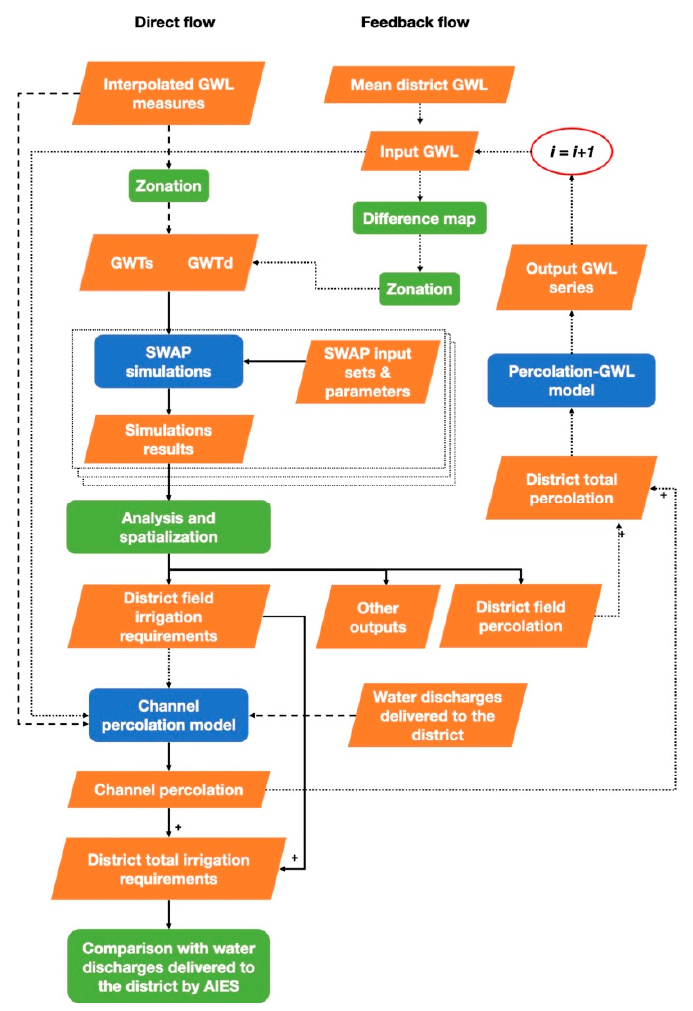
Figure 6. Flowchart of the simulation system illustrating: datasets (orange parallelograms), operations (green rectangles), models (blue rectangles), general flow path (solid lines), direct flow path followed for 2015 and 2016 (dashed lines), feedback flow path followed for 2013, 2014 and hypothetical scenarios (dotted lines), white circular area ‘i = i + 1’ represents where a new loop starts.